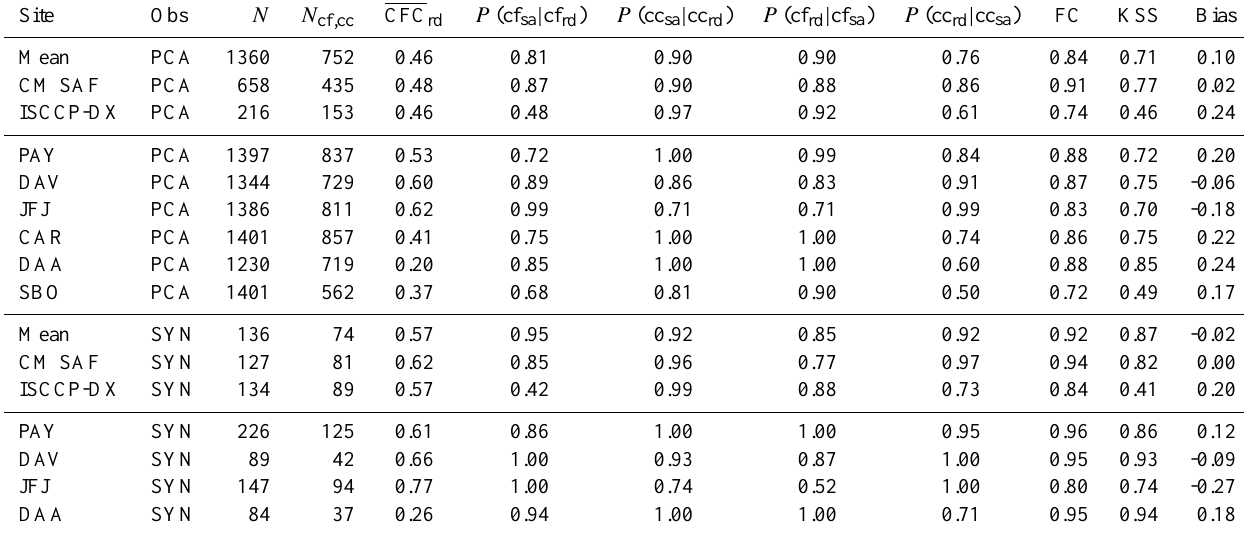
Table 2. Average station-based results of HelioFTH (sa) and surface CFC observations (rd) for April 2004 – obs=reference cloud observation at the surface (PCA = partial cloud amount, SYN=synoptical observation), N =number of all available surface values, N cf,cc =number of only clear-cloudy surface values, FC=fraction correct, KSS=Kuiper Skill Score and bias=mean (satellite − surface). For comparison the mean results for CM SAF and ISCCP-DX CFC products are also